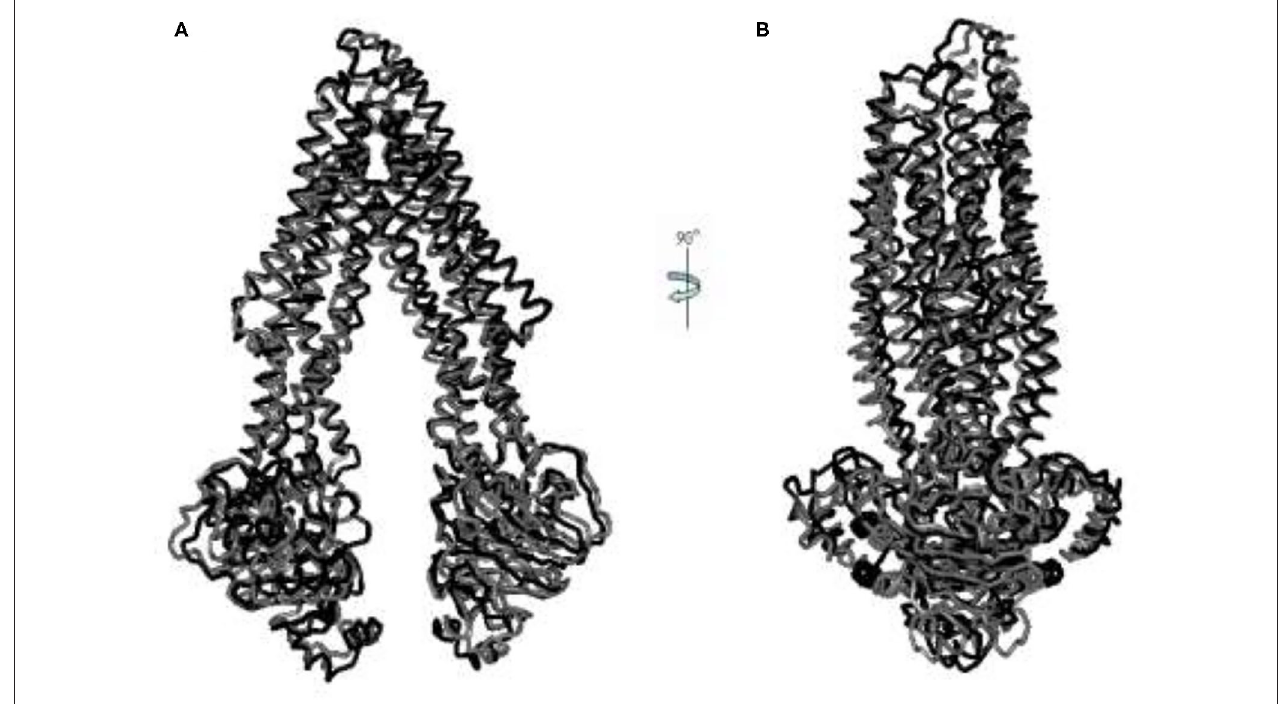
FIGURE 2 | (A,B) The aligned figures of tr_39 and IF_2009. The RMSD of tr_39 (black) and IF_2009 (gray, template: 3G5U, resolution: 3.8 Å) is 4.026 Å.